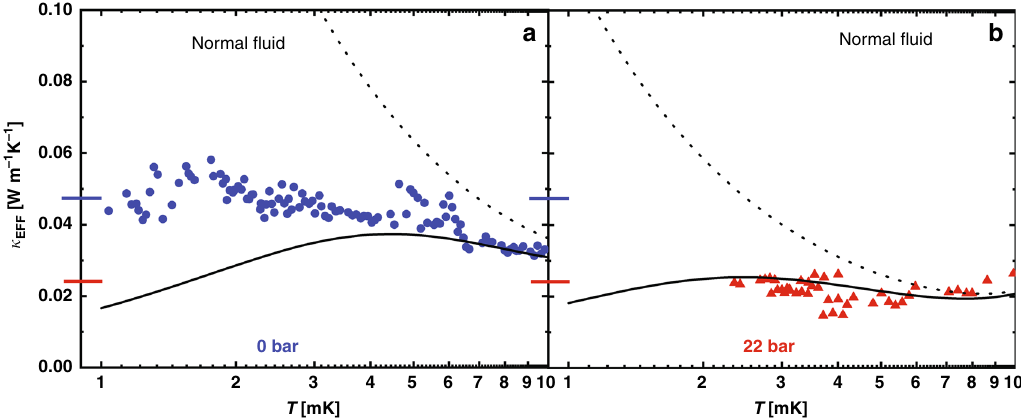
Fig. 4 Normal state thermal conductivity. The thermal conductivity κ EFF ( T ) at 0 bar ( a — blue circles) and 22 bar ( b — red triangles) <10mK in the normal state calculated from geometrical parameters and R th ( T ). Also shown are the expected T − 1 bulk behaviors (dotted lines) exhibiting the T − 2 dependence of inelastic scattering of Bogoliubov quasiparticles. The solid lines show the thermal conductivity expected for a distribution of point scatterers that give rise to a mean free path of 1.1 μ m. The horizontal lines de fi ne the values for κ EFF ( T ) at 0 bar (blue 0.047±0.005WK − 1 m − 1 ), and 22 bar (red 0.024±0.003WK − 1 m − 1 ) as T c is approached in the normal